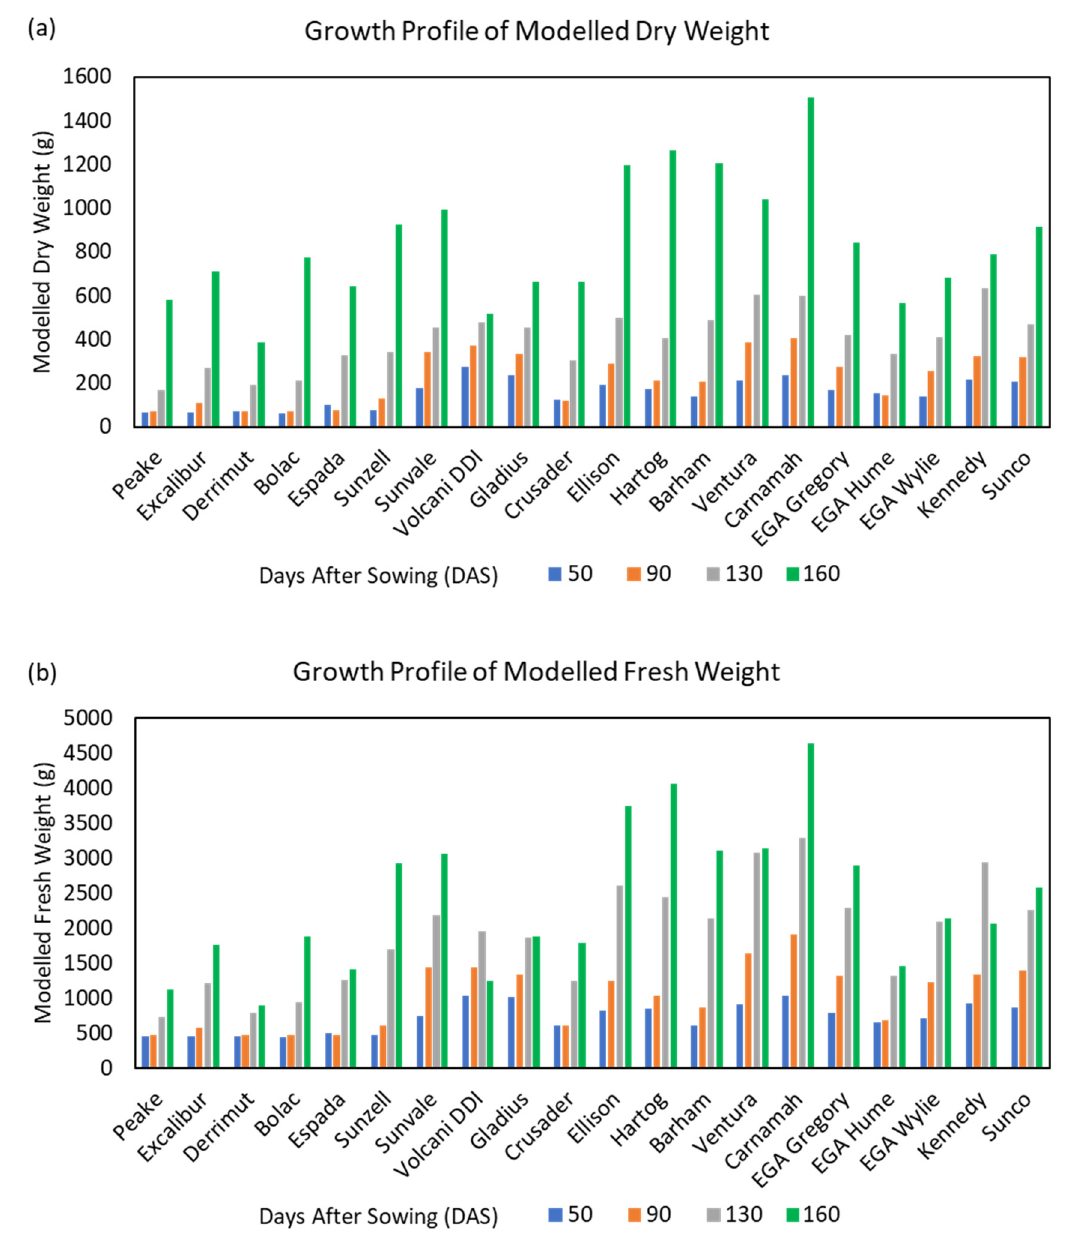
Figure 7. Growth profile of wheat genotypes at di ff erent time points. Using modelled ( a ) Dry weight and ( b ) Fresh Weight.